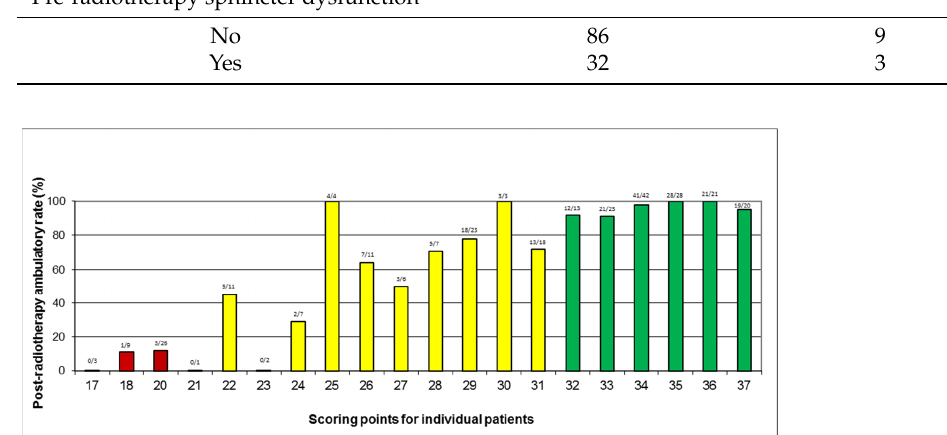
Commented [M6]: Please add the explanation of colour red, yellow and green in the figure caption, same as Figure 2. Added